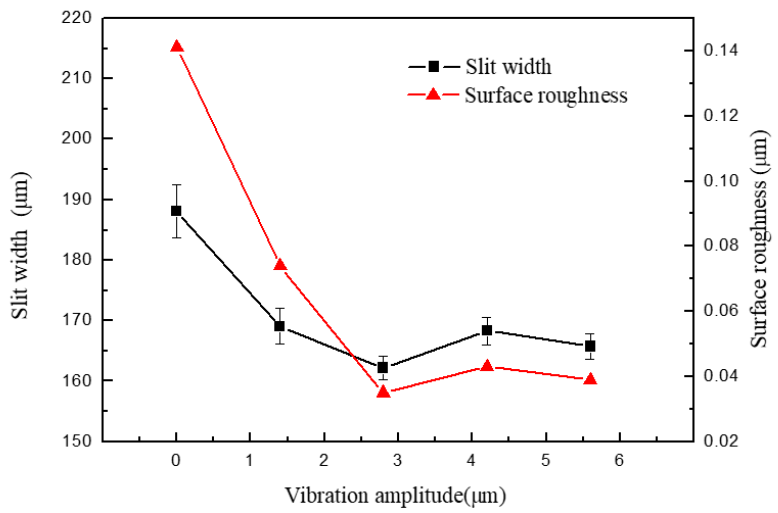
Figure 8. Variations in slit width and surface roughness with vibration amplitude.